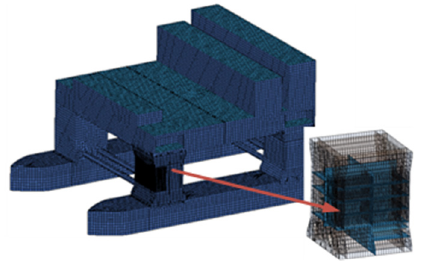
Figure 3. The internal structure of the collided column.